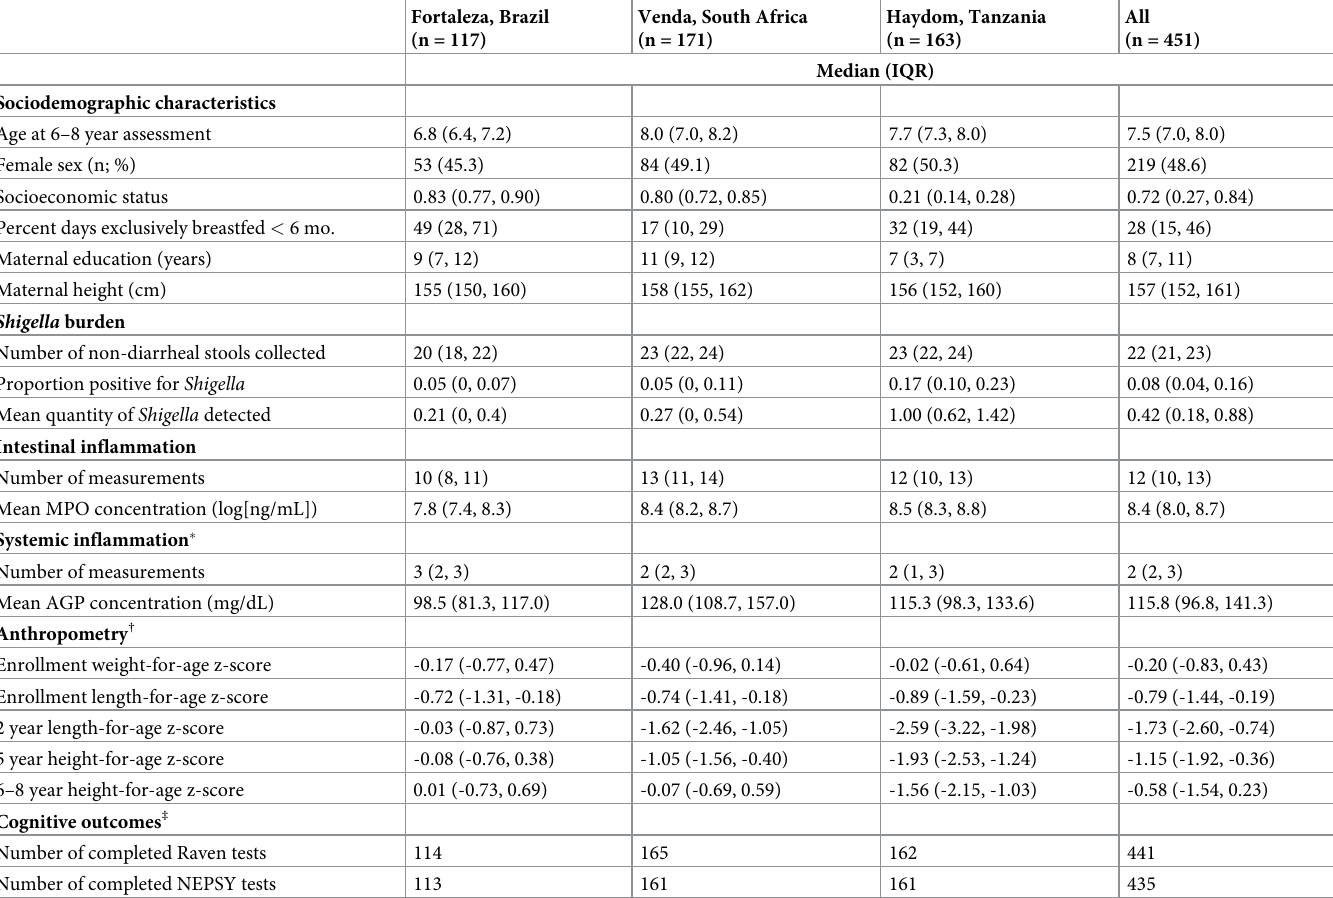
Table 1. Sociodemographic characteristics, burden of Shigella and inflammation in the first 2 years of life, and growth through 6–8 years of age among 451 children in the Brazil, South Africa, and Tanzania MAL-ED cohorts.